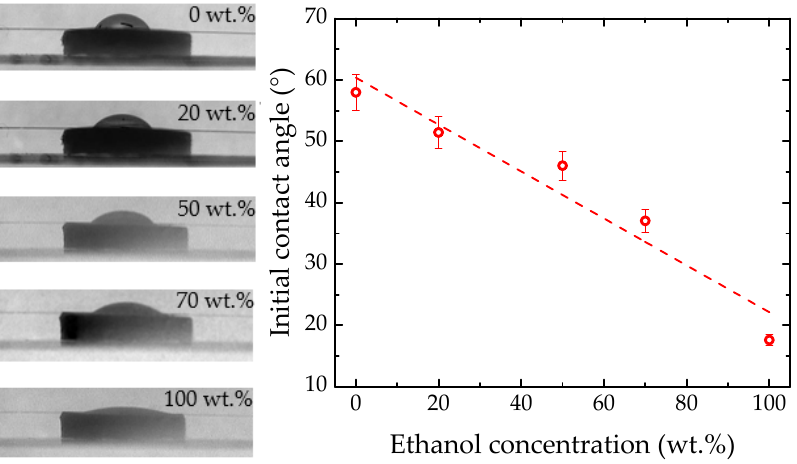
Figure 8. ( left ) Pictures of the droplet profile acquired of the studied ethanol solutions, for both glass and Teflon substrates. ( right ) Initial contact angles of the droplets of ethanol–water mixtures on both glass and Teflon substrates.